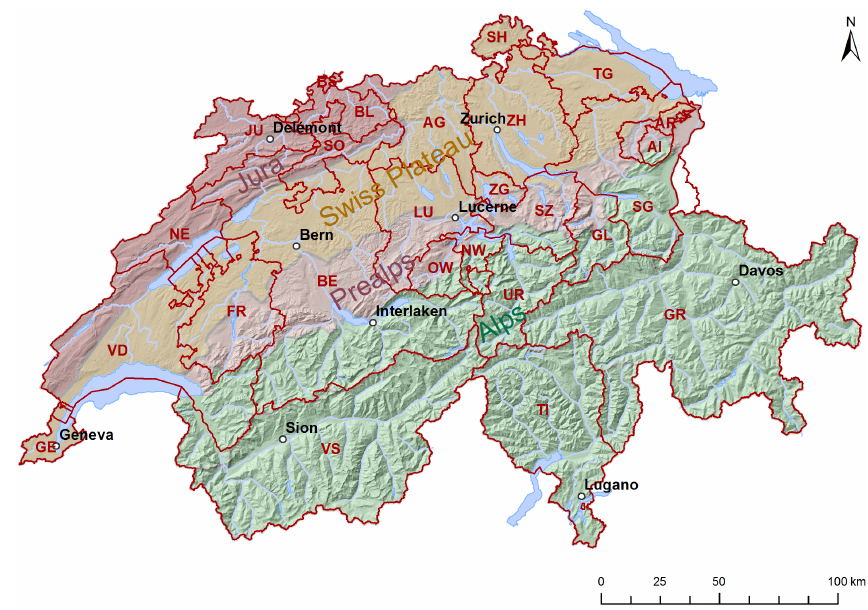
Figure 1. Study area showing the Swiss stream network, the Swiss cantons (red polygons with abbreviations; see BFS, 2016), the geomorphologic-climatic regions Jura, Swiss Plateau, Prealps, Alps (areas with different background colours) and several key cities (DHM source: dhm25 © 2016 swisstopo, 5704 000